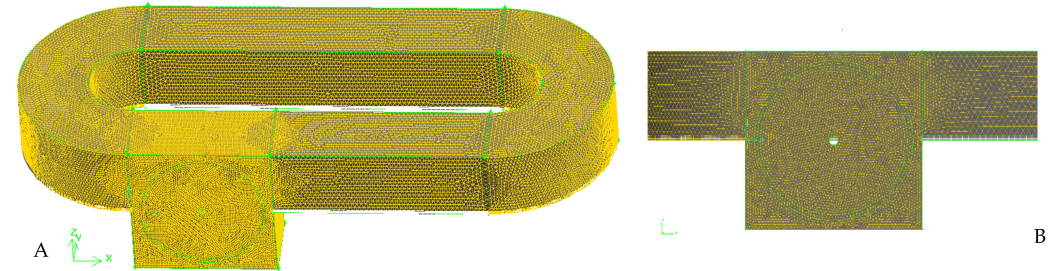
Figure 3. The grid division of the flume model and the details of the wheel position. ( A ) Global grid diagram, ( B ) grid diagram of the wheel